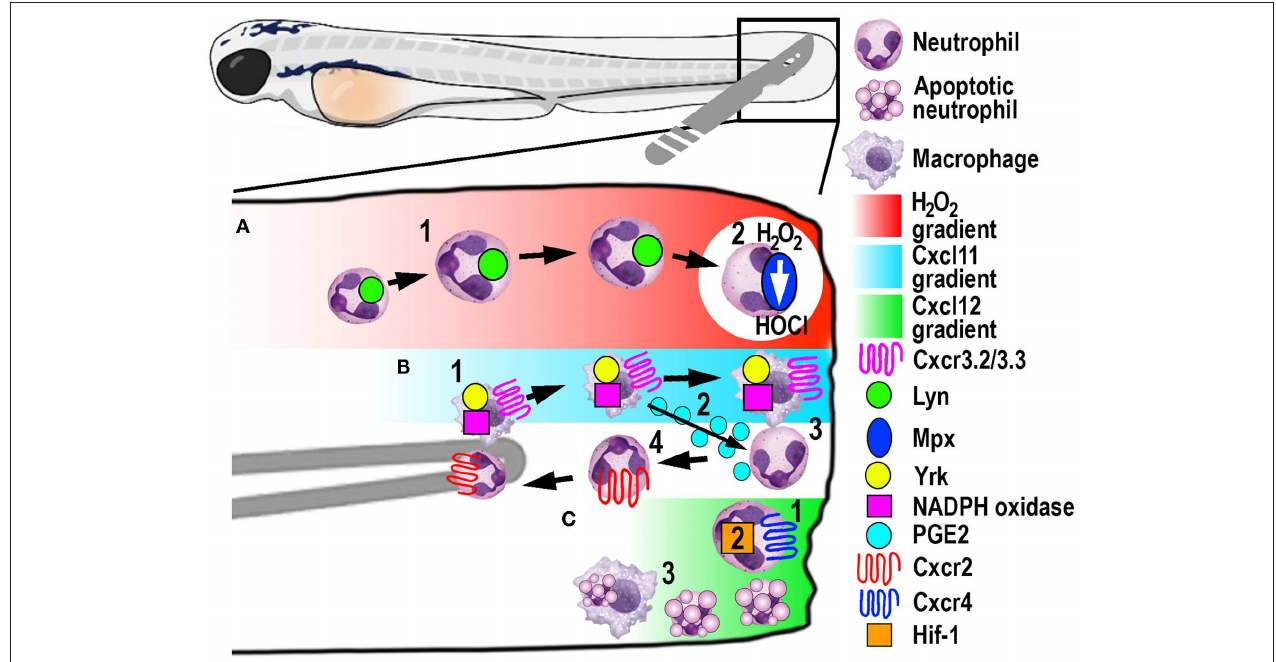
FIGURE 4 | Schematic illustration of the signaling pathways and mechanisms that help control phagocyte migration and abundance during larval zebrafish acute tail fin injury. (A) A gradient of H 2 O 2 , generated at the wound margin, is sensed by neutrophils through oxidation of Lyn, leading to directed neutrophil migration (1). Neutrophil-delivered Mpx consumes H 2 O 2 producing hypochlorous acid (HOCl) (2). (B) Macrophage arrival at the wound site is promoted by NADPH oxidase activity and Yrk, in addition to Cxcr3.2/Cxcl11(1). In this context, Cxcr3.3 acts as a scavenger receptor to negatively regulate Cxcr3.2 function. Macrophage-delivered PGE2 promotes neutrophil retrograde chemotaxis (2) together with NADPH/Yrk-dependent contact-mediated guidance from macrophages (3). Cxcr2 signaling also contributes to initiate neutrophil retrograde chemotaxis (4). (C) Cxcr4/Cxcl12 signaling contributes to the retention of neutrophils at the wound site (1) along with Hif-1 activation (2). Macrophages at the wound site also remove apoptotic neutrophil debris